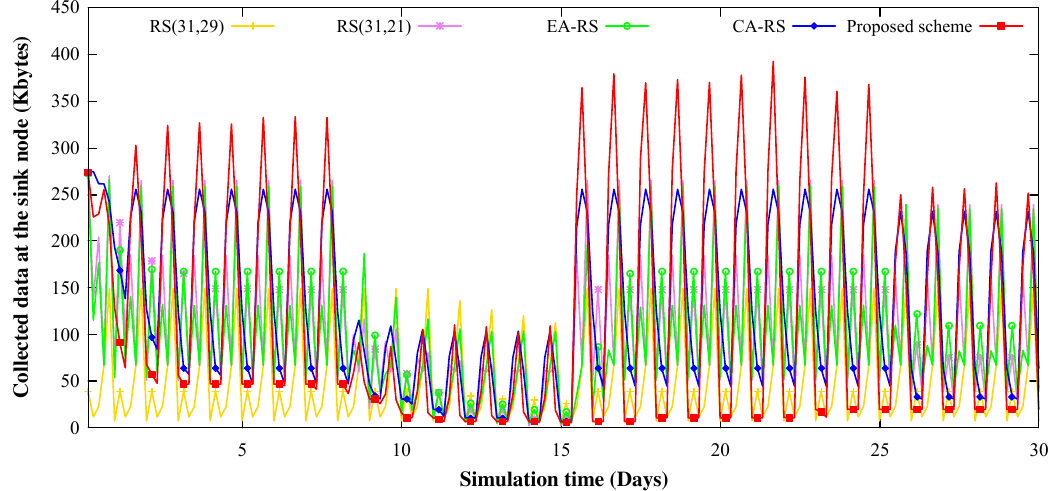
Figure 10. Change in the collected data at the sink node, according to the simulation time for 150 nodes and 0.15 BER (9th ∼ 15th day: rainy, 26th ∼ 30th day: cloudy; others: